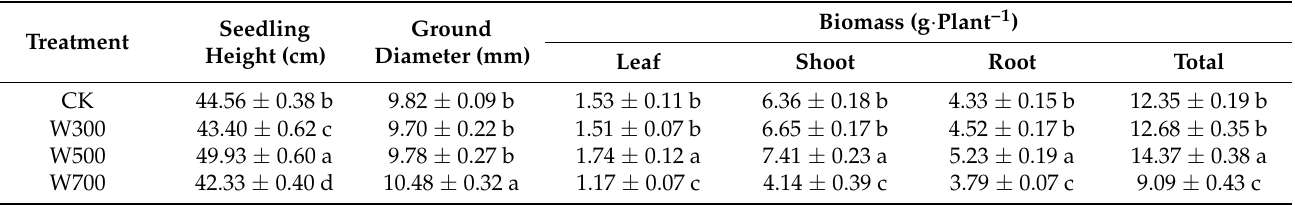
Table 3. Effects of wheel wingnut-based biochar pyrolyzed at different temperatures on growth and biomass accumulation of C. paliurus seedlings after 200 days of